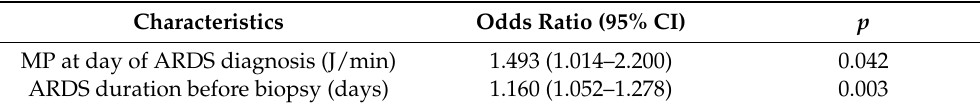
Table 4. Factors associated with histological fibrosis at open lung biopsy using a multivariable logistic regression